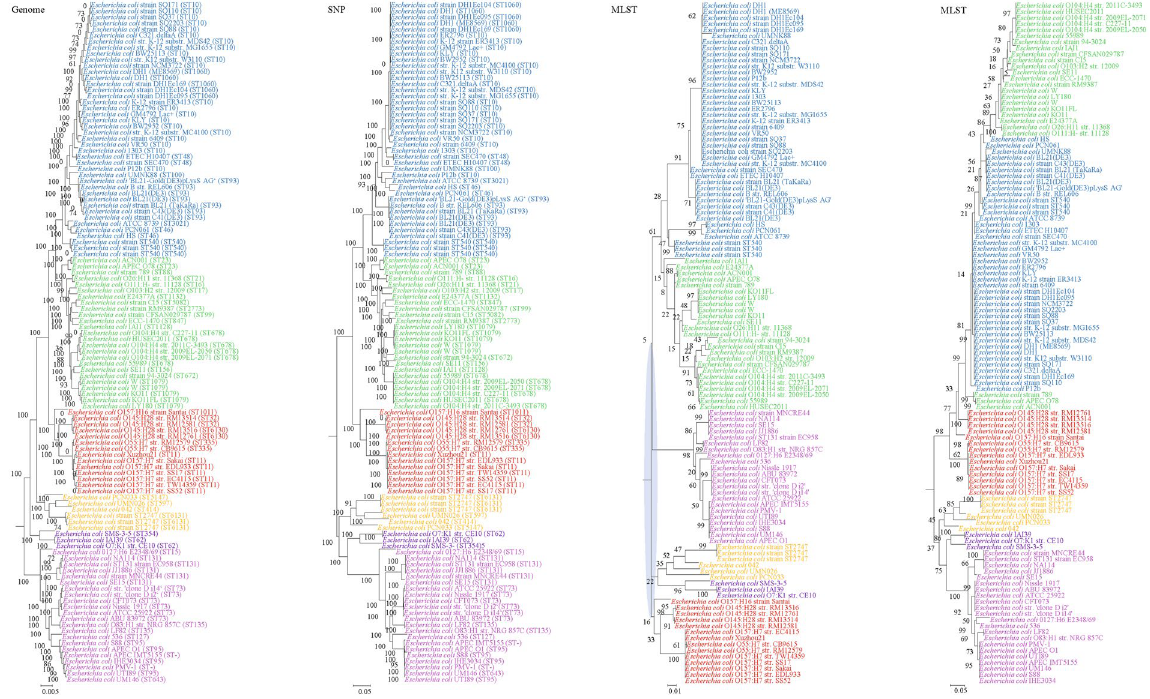
Figure 5. Comparison of phylogenetic trees constructed using genome data (left), SNP data (middle), and MLST data (right) for Escherichia coli (two MLST schemes). Clusters that were manually selected based on the genome trees are illustrated in different colors. The unresolved polytomies are shaded in blue. A new sequence type is represented by a dash